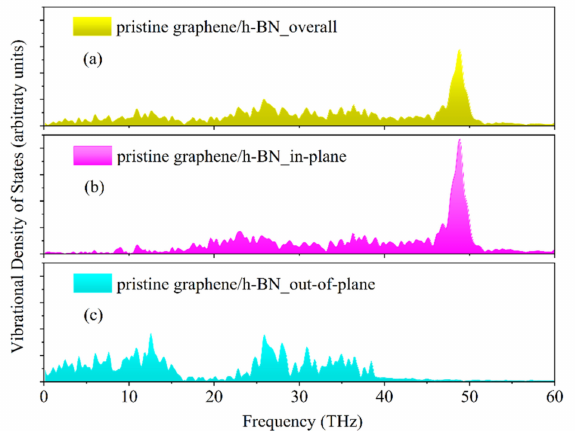
Figure 6. ( a ) Total VDOS, ( b ) in-plane VDOS and ( c ) out-of-plane VDOS in the near-interface region of pristine